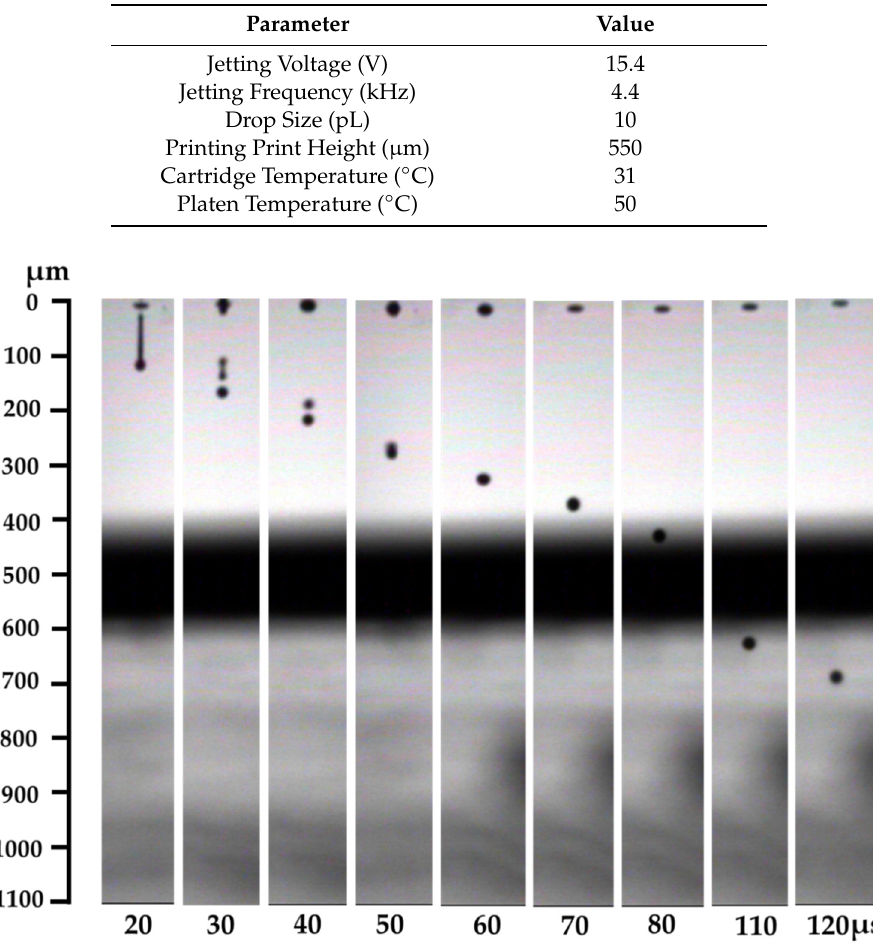
Figure 1. Drop formation of ink from a single nozzle in different time frame. Satellite droplets were formed at 30 µ s and retracted after 50 µ s. (For 90 and 100 µ s, the droplet was in the shadowed part, which was not given in the figure).